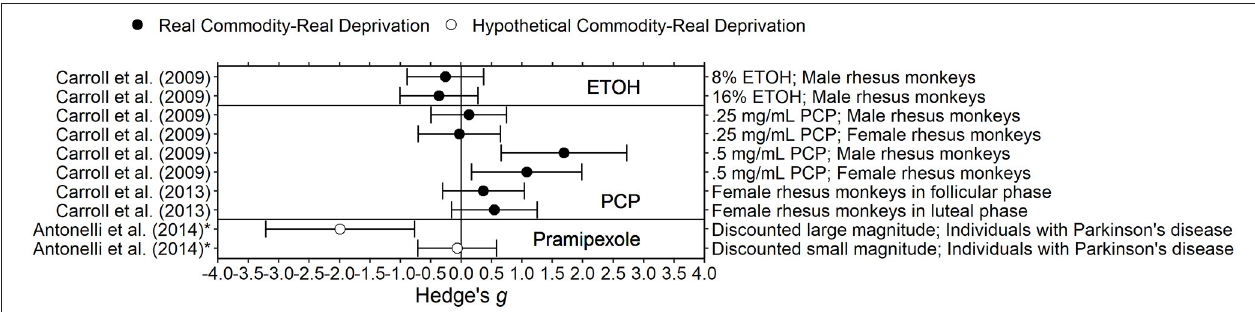
FIGURE 5 | Effect sizes for other drug deprivation experiments. Effect size is Hedge’s g . Points closer to 0 indicate smaller effect sizes. Points to the right of the line indicate increases in delay discounting due to deprivation, the predicted effect. Solid circles indicate that the delay discounting task used real outcomes and subjects experienced real deprivation. Unfilled circles indicate that the delay discounting task used hypothetical outcomes and subjects experienced real